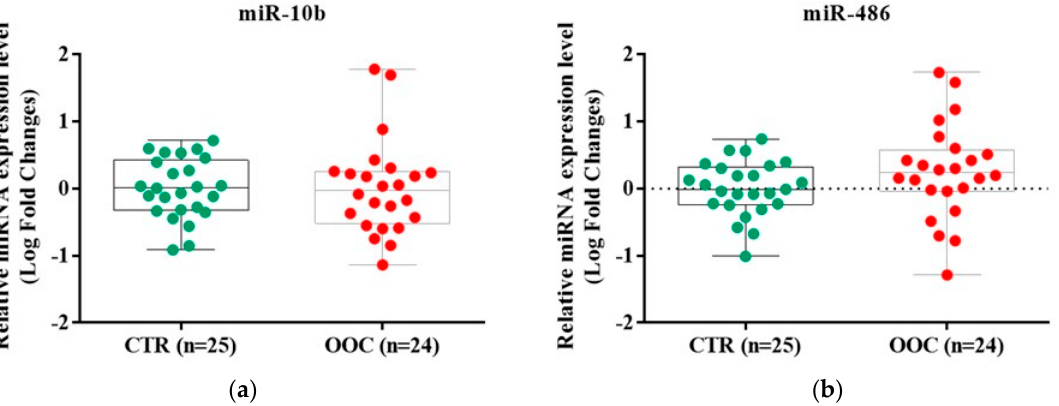
Figure 3. The evaluation of microRNAs expression profile in cancer and healthy samples using RT ‐ qPCR method; ( a ) Difference between the expression level of miR ‐ 10b ‐ 5p in cancer and control groups; ( b ) Difference between the expression level of miR ‐ 486 ‐ 5p in cancer and control groups. The data were normalized to U6 and RNU48 using the ΔΔ CT method. Data were analyzed using Mann ‐ Whitney ‐ Wilcoxon rank sum test and represented as Log of Fold Change. The miR ‐ 10b ‐ 5p expression level presented no difference between oral cavity cancer (1.38 (0.35, 1.75 LR fold changes) and oropharyngeal cancer (1.38 (0.35, 1.75) LR fold changes). The miR ‐ 486 ‐ 5p expression levels were elevated in in oropharyngeal cancer (2.11 (1.90, 2.33) LR fold changes) compared to oral cavity cancer (1.44 (0.80, 4.48) LR fold changes). The results were not statistically significant. Table 2 summarizes the miRs expression according to the tumor stage, grading, and keratinizing status. Stage II had a higher upregulation of miR ‐ 486 ‐ 5p expression than